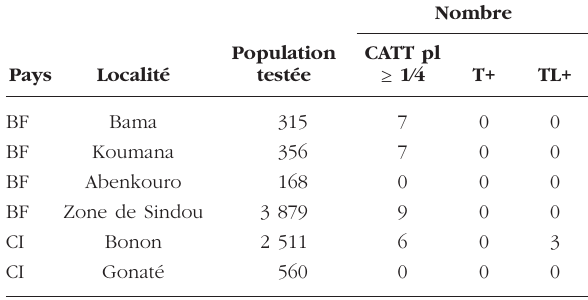
Tableau I. – Résultats des prospections médicales menées au Burkina Faso et en Côte d’Ivoire en 2010 et